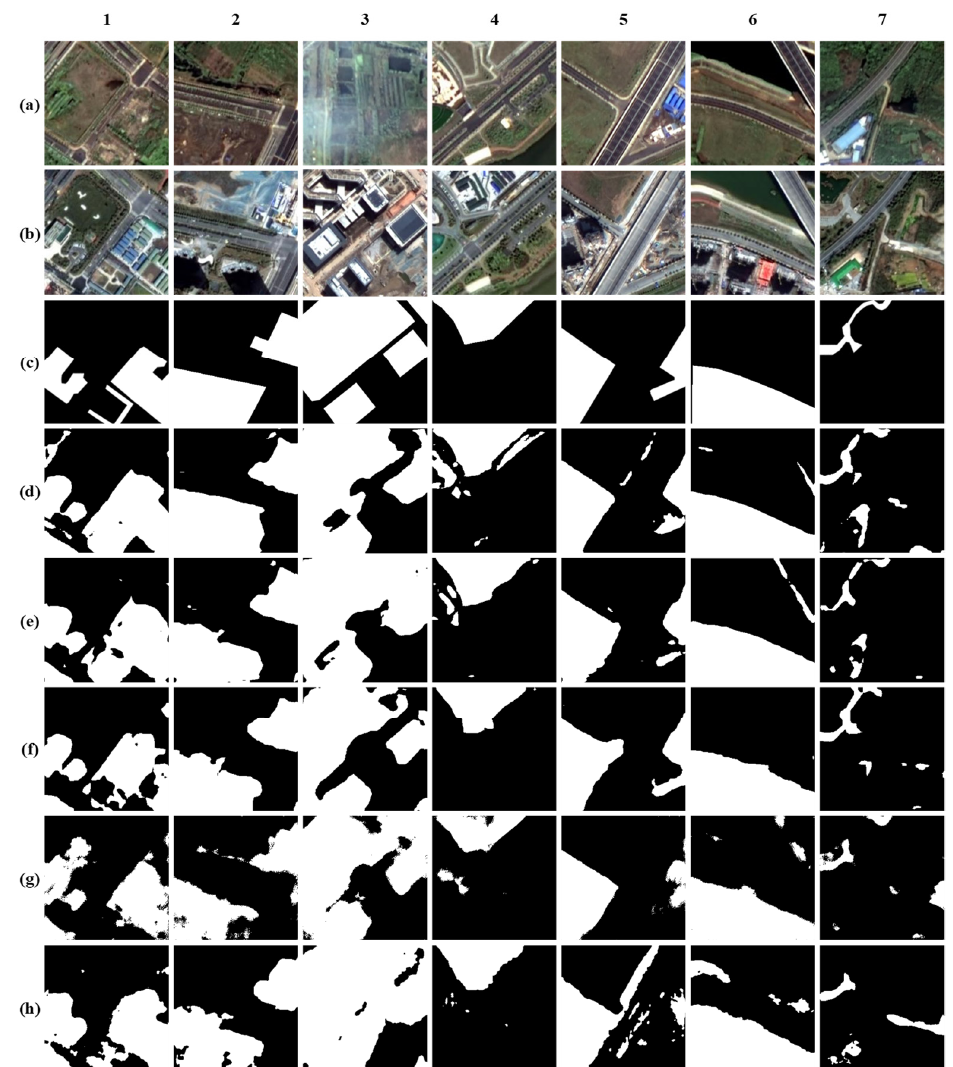
Figure 5. Comparison of change detection outputs. ( a ) Image 1 in 2015, ( b ) Image 2 in 2020, ( c ) ground truth and result from ( d ) STANet-BASE, ( e ) STANet-BAM, ( f ) STANet-PAM, ( g ) SNUNet, and ( h ) BiT models individually. White and black regions denote the change area and no change area, respectively.